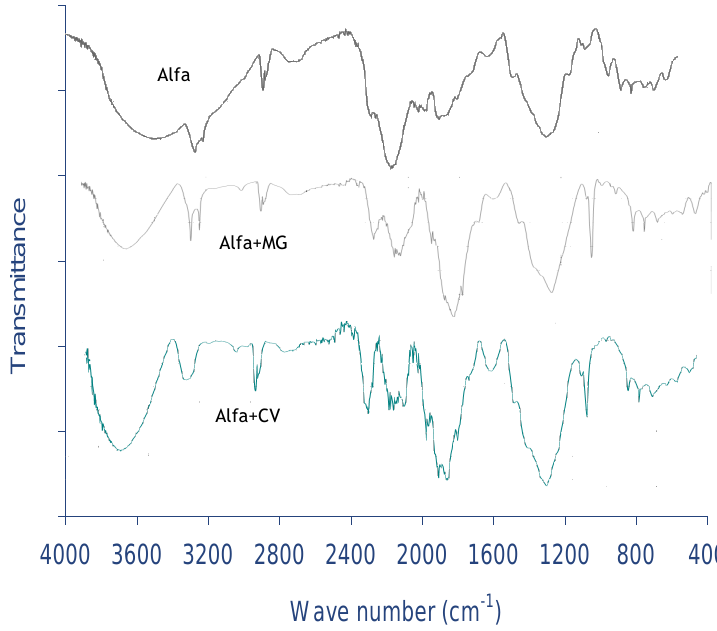
Figure 1. FTIR spectrum of Alfa leaf powder (ALP).